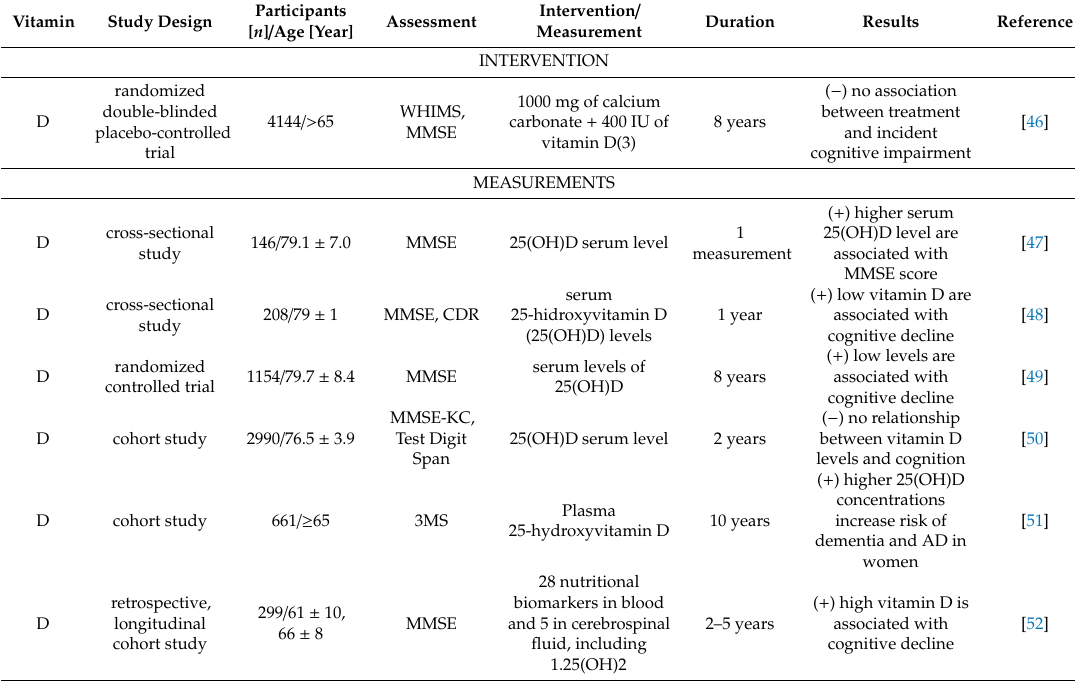
Table 5. Summary of studies on vitamin D supplementation and blood measurements in